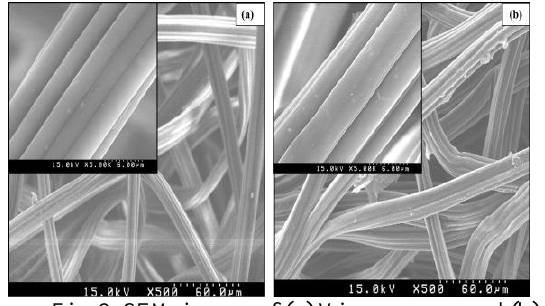
Fig. 2, SEM images of (a) Viscose rayon and (b) Viscose rayon